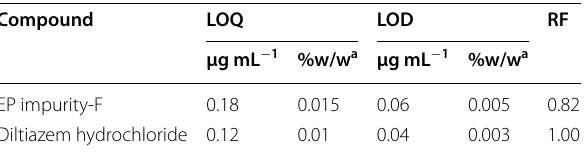
Table 7 Recovery for diltiazem hydrochloride